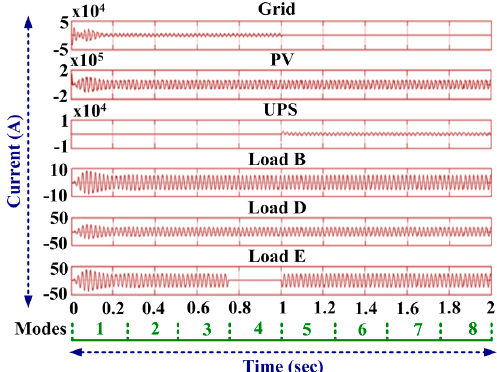
Figure 12. Output current of (top to bottom: grid, PV, UPS, load B, load D, and load E.